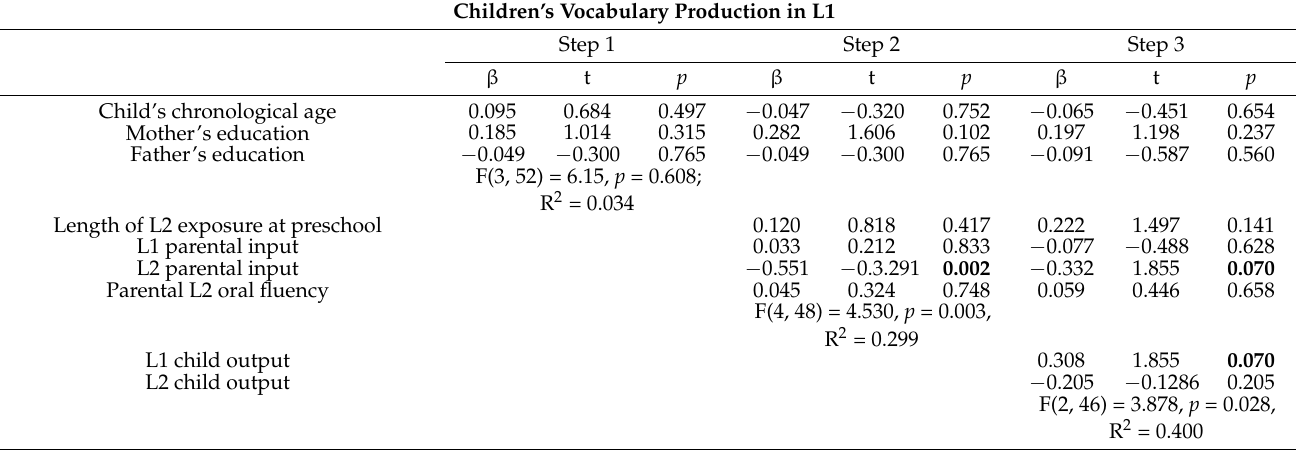
Table 3. Summary of the stepwise regression analyses with steps 1, 2 and 3 for children’s vocabulary production in L1 and